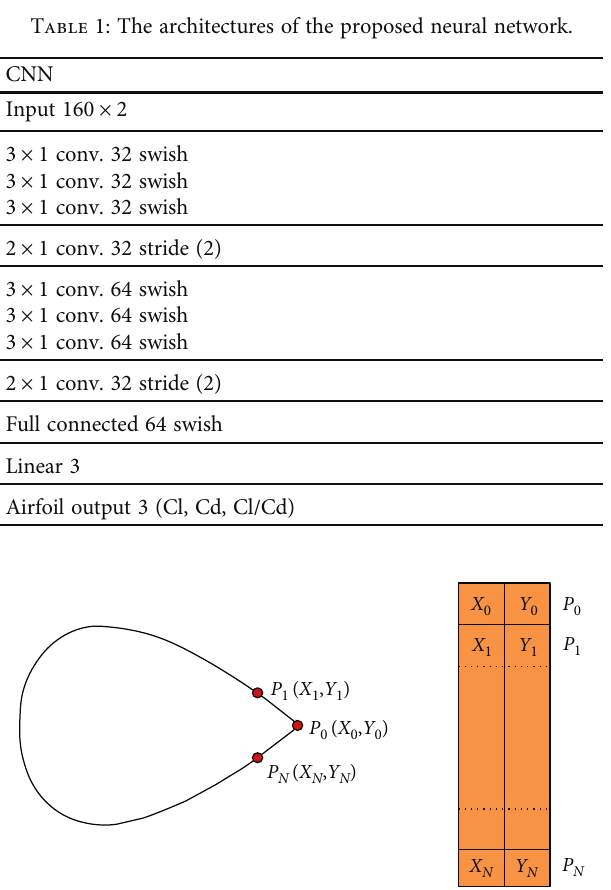
Figure 3: The airfoil curve and the input coordinate